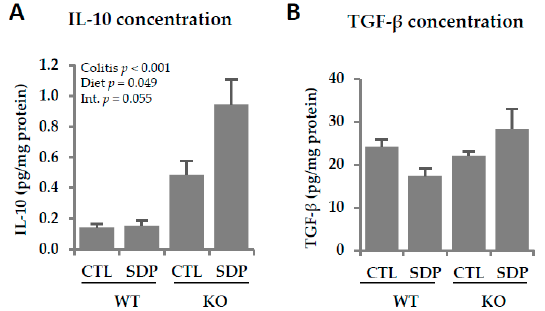
Figure 6. Effects of SDP supplementation on anti-inflammatory cytokine secretion in the colonic mucosa of Mdr1a KO mice. ( A ) IL-10 concentration; ( B ) TGF- β concentration. Results are expressed as mean ± SEM ( n = 5–7 mice / group). CTL, control; IL-10, interleukin-10; Int., interaction between colitis and dietary factors; SDP, spray-dried porcine plasma; TGF- β , transforming growth